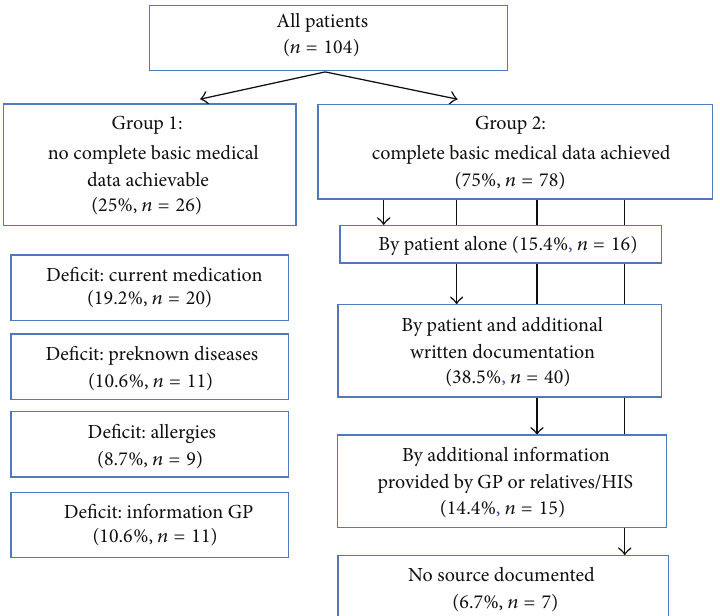
Figure 1: Distribution of patients included (Groups 1 and 2) (total number and % of all patients included): Group 1: no complete basic medical data achieved: single item deficit. Group 2: complete basic medical data achieved: by what means.